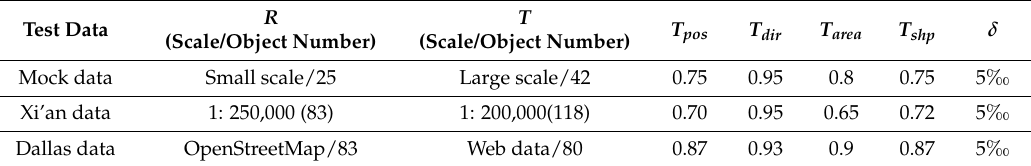
Table 1. Experimental data statistics and parameter settings.